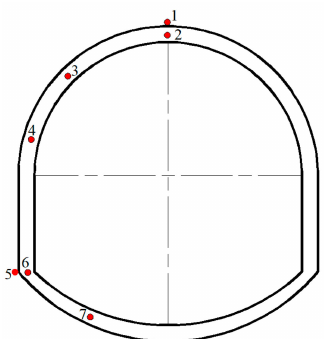
Figure 18. The layout of the monitoring points. Figure 18 shows the stress-strain diagrams of the RB sets.